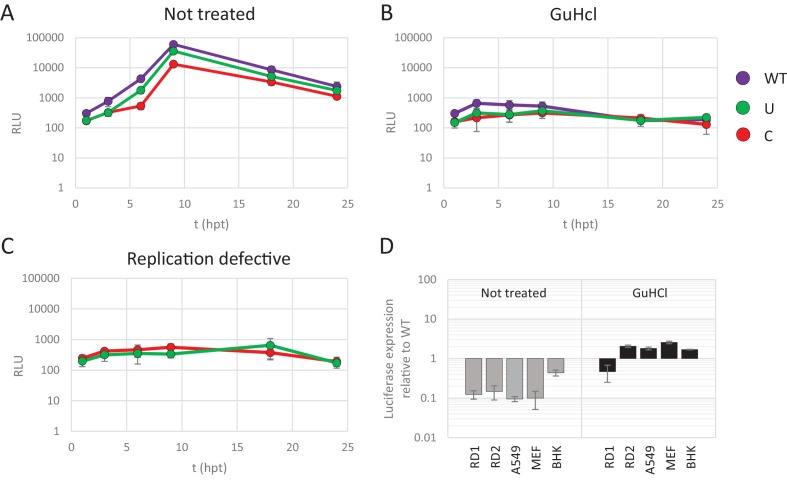
Reduced replication of E7 replicon RNA with increased CpG and UpA dinucleotides is not the result of reduced translation.(A–C) E7 replicon RNA with ncR1 extensions of either wild type (WT), UpA high (U) or CpG high (C) composition were transfected into RD cells. Cells were either not treated (A) or treated with guanidine hydrochloride (GuHCl) (B) to inhibit E7 RNA replication. Similarly, RD cells were transfected with RNA of replication-defective E7 replicons with ncR1 of either WT or C composition (C). Firefly luciferase was measured at the indicated times post transfection (hpt). (D) Indicated cell types were transfected with E7 replicon RNA with either the WT or CpG-high ncR1 sequence. RD1 shows the six hour time point from panel A and B, while RD2 is a second independent experiment in RD cells. Cells were either treated with GuHCl or left untreated. At six hpt luciferase expression was measured. Bars show the fold change in luciferase expression of the E7 replicon with the CpG-high ncR1 relative from that of their respective not treated or GuHCl treated WT. (A–D) Data points represent the mean of three biological replicates. Error bars represent one standard error of the mean.